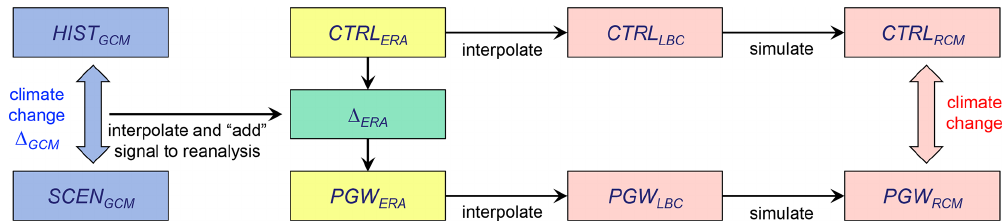
Figure 2. Workflow for PGW simulations. The strategy consists of imposing large-scale changes in thermodynamic structure and circulation on a historical RCM simulation by modifying the lateral and lower boundary conditions correspondingly. The climate change signal is taken from GCM simulations. Here CTRL and PGW represent the historical and pseudo-global-warming simulations, driven by historical and modulated reanalysis, respectively. The subscripts denote the underlying computational mesh, represented by the GCM, the reanalysis ERA, the regional climate model RCM, and the lateral and lower boundary conditions LBC driving the RCM. Note that the LBC and RCM meshes are typically